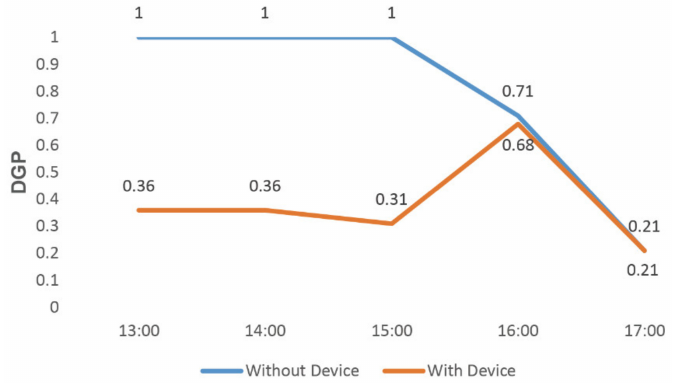
Figure 26. Product simulation on 20 February.